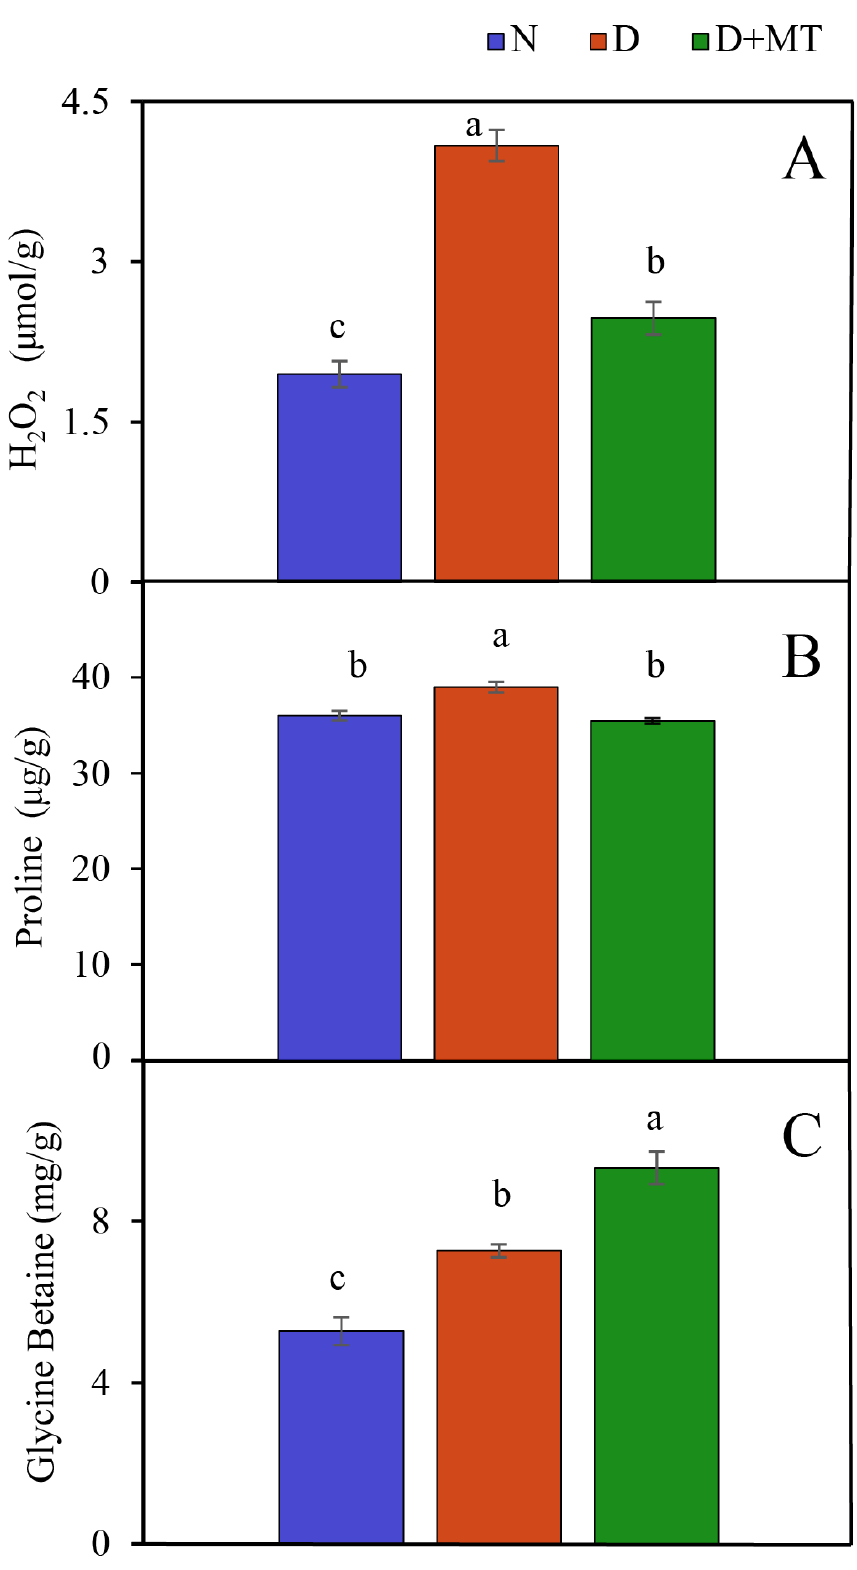
Figure 1. Concentrations of H 2 O 2 , proline and glycine betaine in barley leaves as affected by melatonin treatment and drought stress. The letters ( A – C ) corresponds to H 2 O 2 , proline and glycine betaine concentrations, respectively. Data are reported as mean ± SE (H 2 O 2 and proline, n = 4; glycine betaine, n = 3). Different small letters indicate significant differences at the p < 0.05 level. N, normal control; D, drought stress; D + MT, melatonin + drought stress.